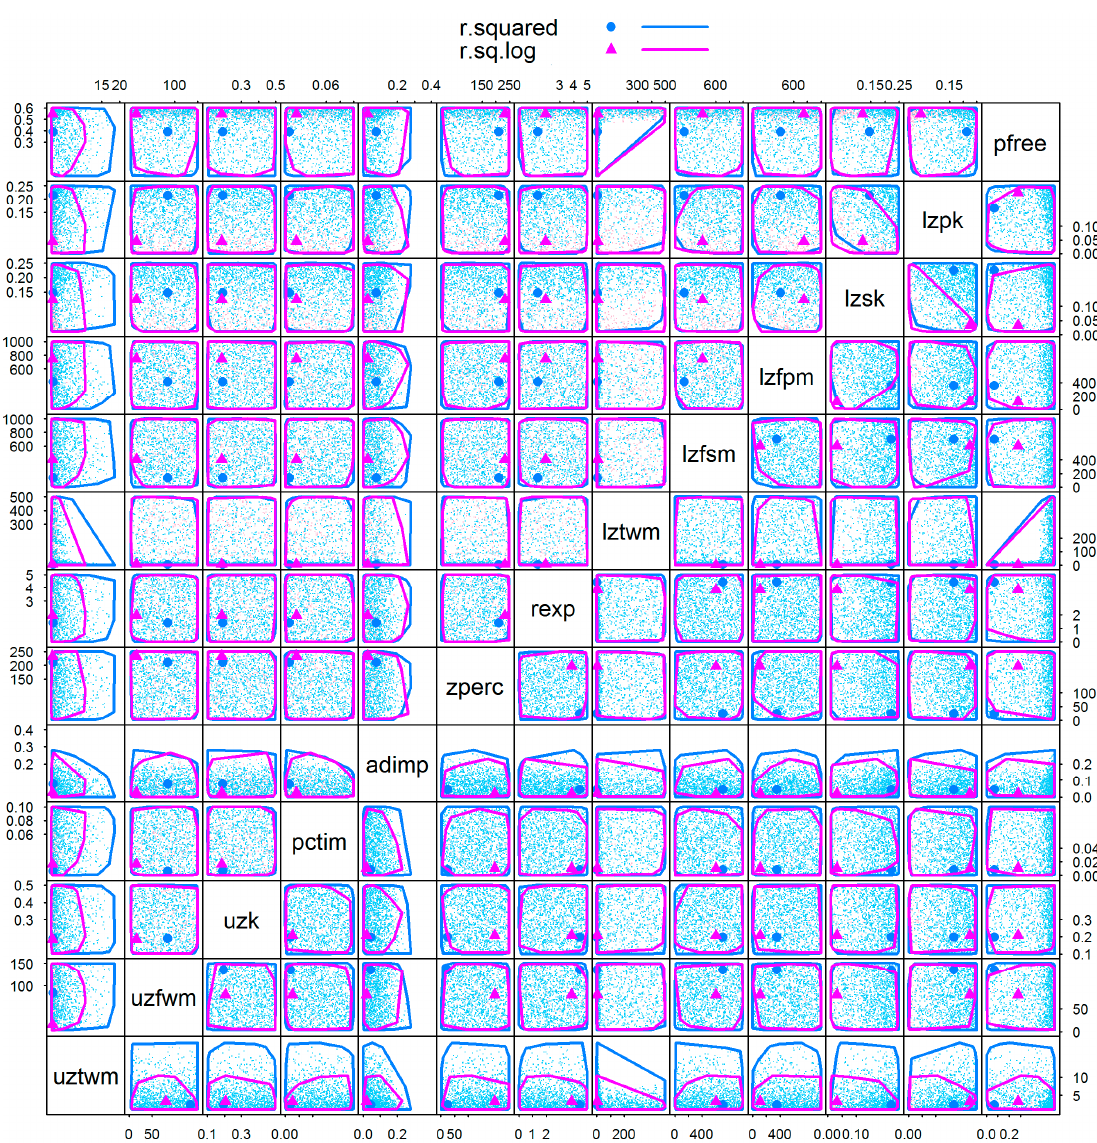
Figure 7. Two-dimensional projections of the pairwise correlation of behavioral parameters for the Sacramento model using CMADS (above diagonal) and TMPA-3B42V7 (below diagonal) precipitation datasets. The heavy dots represent the location of the best objective function value obtained from the GLUE sample.